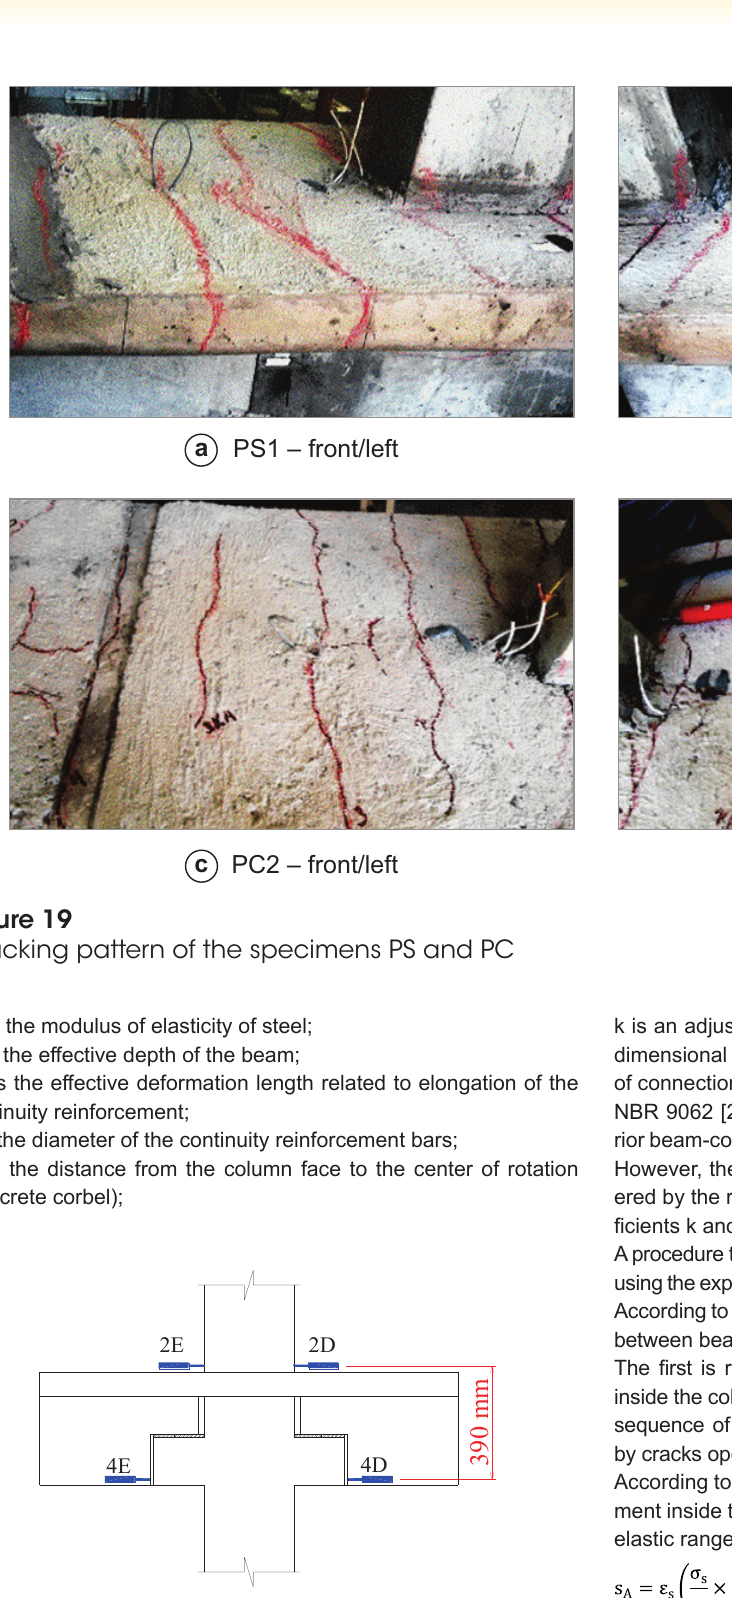
Figure 20 – LVDTs used to determine relative rotations for all LVDTs used to determine relative rotations for all specimens